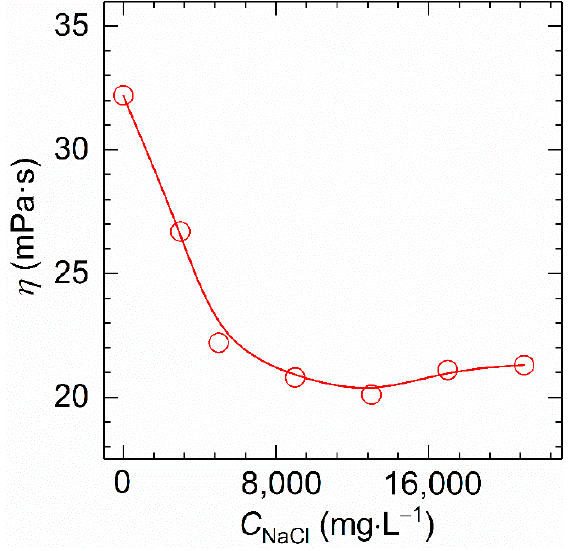
Figure 7. Variation of the apparent viscosity versus NaCl concentration for 1700 mg · L − 1 HVFR at 30 °C.